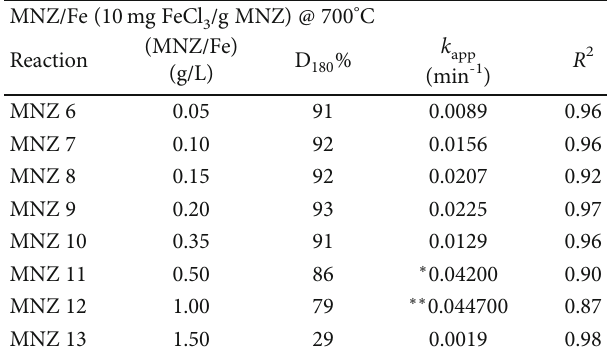
Table 7: RB5 dye discoloration using MNZ/Fe as